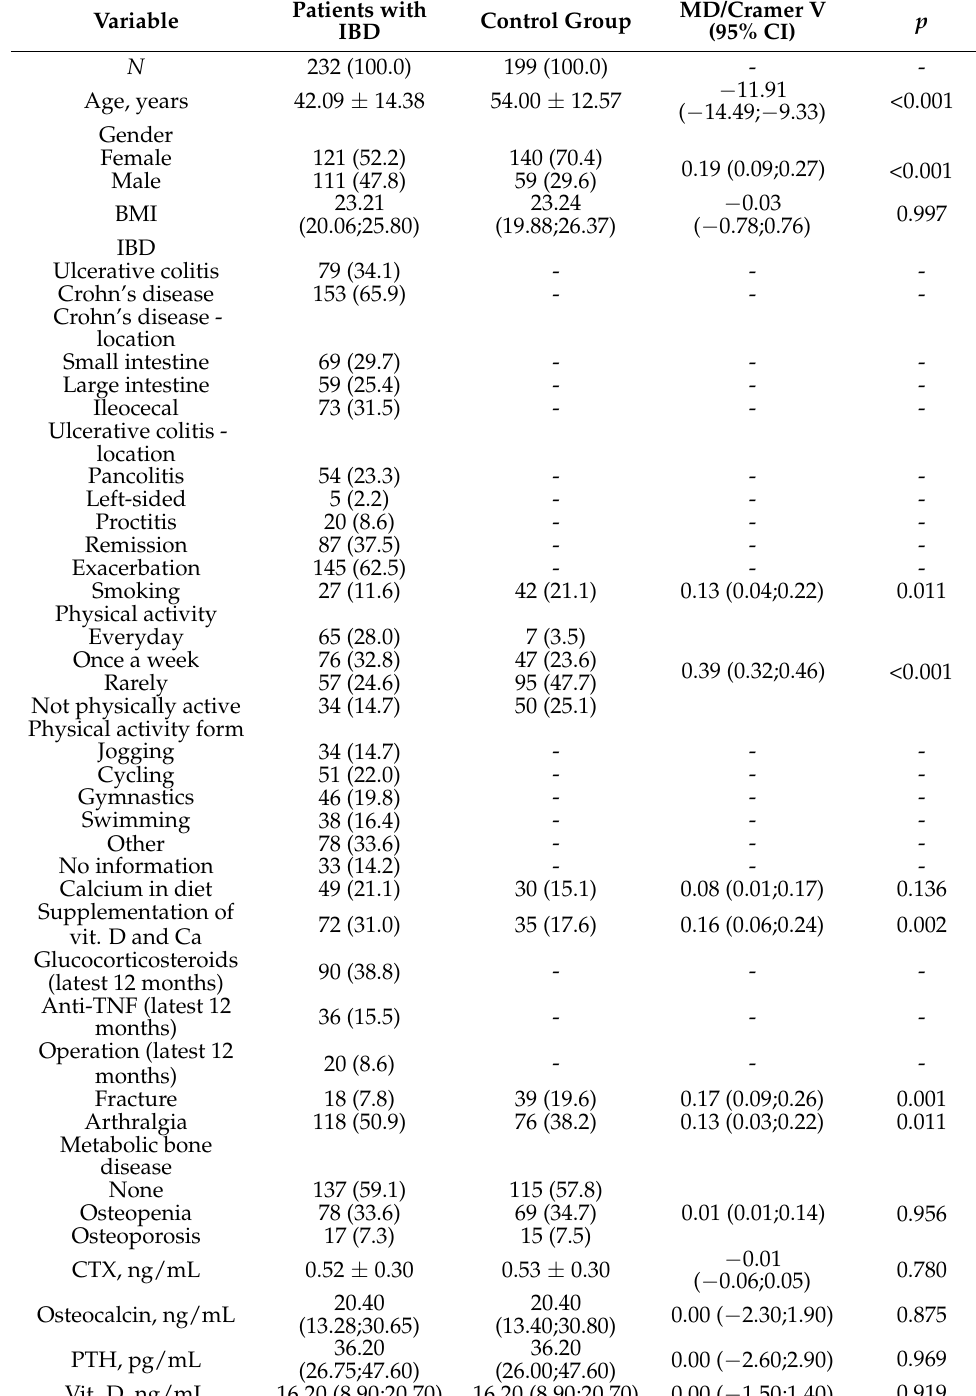
Table 1. Characteristics and comparison of study